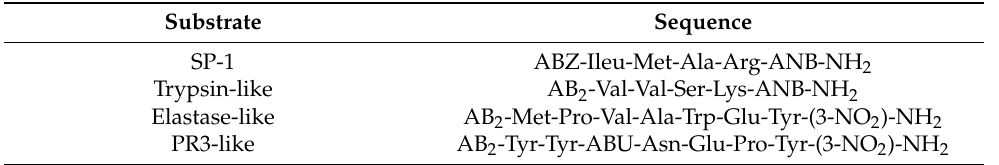
Table 2. Specific